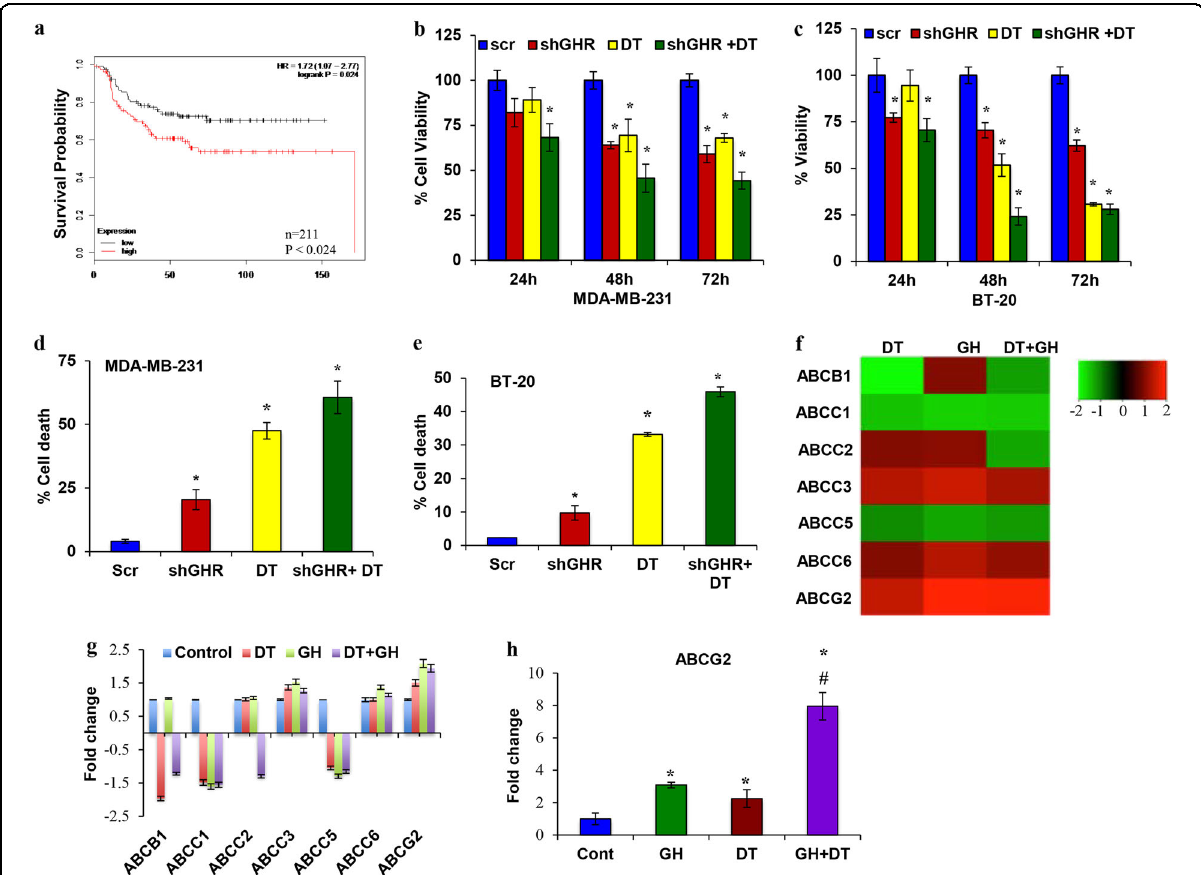
Fig. 3 Increased GHR expression is associated with chemoresistance. a KM plotter survival probability of ER − ve breast cancer patients ( n = 211) with low or high GHR expression who underwent chemotherapy. b and c GHR knockdown increased the sensitivity of ER − ve breast cancer cells to DT. GHR-silenced cells were treated with 50 nM DT, and cell viability was measured in MDA-MB-231 ( b ) and BT-20 cells received 5 nm DT and measured the cell viability ( c ). d and e GHR silencing increased the ef fi cacy of DT by increasing apoptotic cell death. f and g Microarray analysis of ABC transporter family of genes involved in drug resistance. MDA-MB-231 cells were treated with DT, GH, or DT + GH and were analyzed for the differential expression of ABC transporter genes and the data is represented as ( f ) heatmap and ( g ) bar diagrams. h RT-PCR of ABCG2 gene expression shows that ABCG2 expression increased in GH and DT alone treatment, while GH plus DT treatment further increases the expression of ABCG2. All the experiments were repeated at least three times. *indicates p < 0.05 compared to respective control; # indicates a signi fi cant difference between